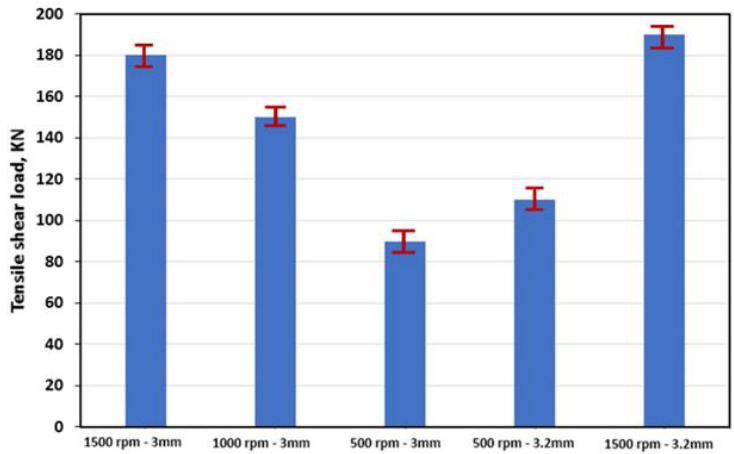
Figure 14. Tensile shear load of the aluminum/steel interface produced with different FSP rotation speeds and pin lengths.